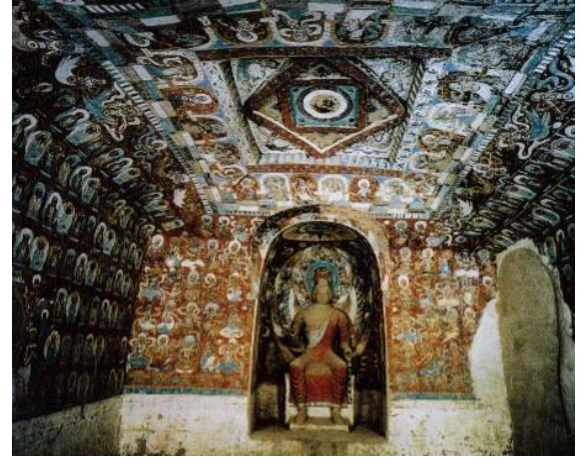
Figure 1. The earliest palace cave of Dunhuang Muogao Caves, 272 palance Caisson.